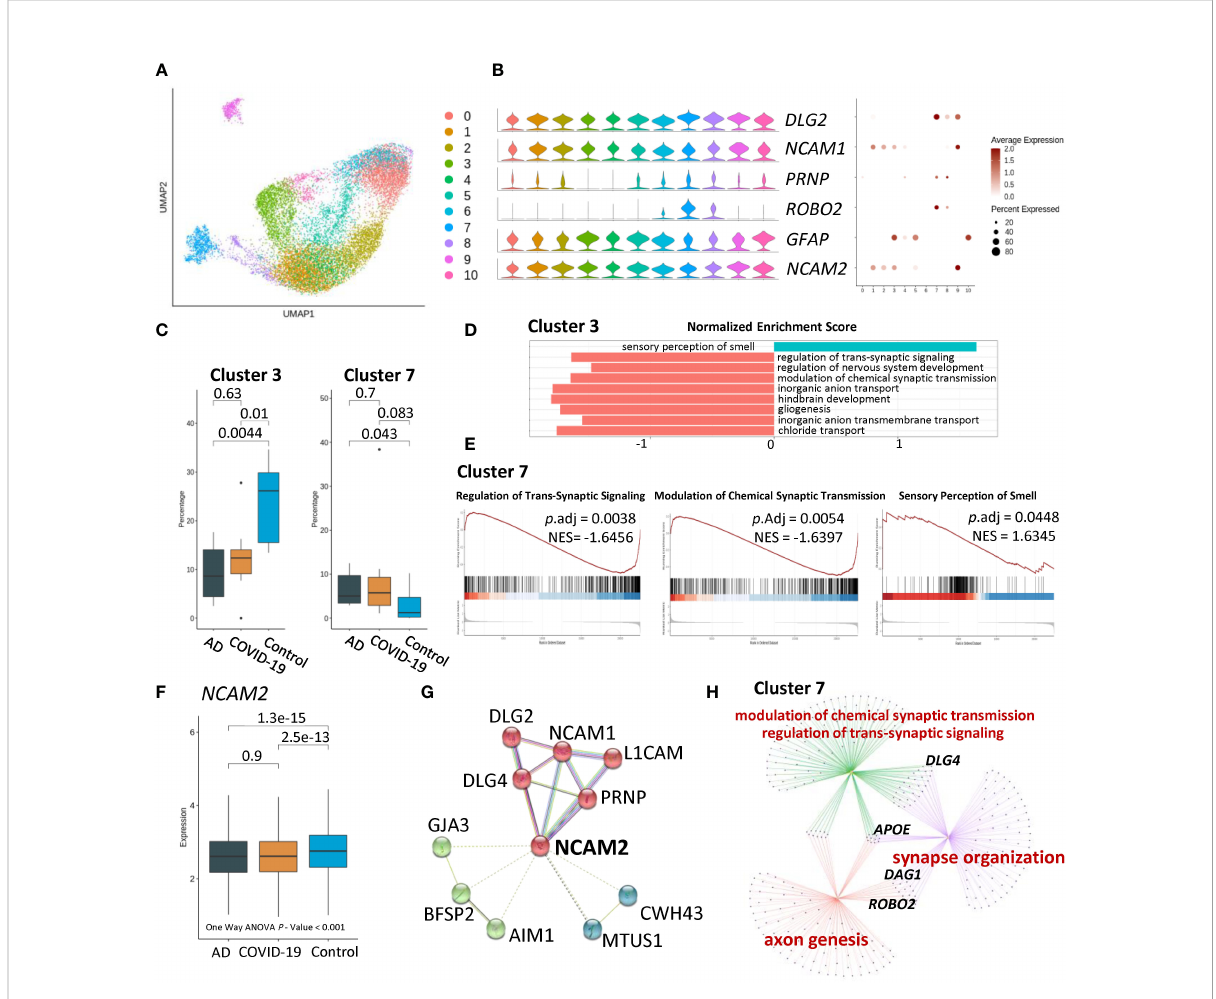
FIGURE 2 Characteristics of disease-associated astrocyte subpopulations. (A) UMAP embedding of all astrocytes coloured by cluster. (B) Violin plots and dot plots showing expression of signature genes of cells. (C) Composition comparison for astrocyte clusters 3 and 7, showing signi fi cant difference between groups. (D) GSEA result of cluster 3 showing upregulated sensory perception of the smell pathway, while downregulated several pathways related to neuron and synaptic. (E) GSEA result of cluster 7 showing a similar tendency in sensory of smell and synaptic-related pathways. (F) Boxplot of expression of NCAM2 in AD, COVID-19, CT groups, showing statistical signi fi cance. (G) Protein – protein interaction of NCAM2 by String Database. Proteins were clustered into 3 clusters. (H) Network of GO results applied in cluster 7, among which APOE, DLG4, DAG1 and ROBO2, as key proteins, are